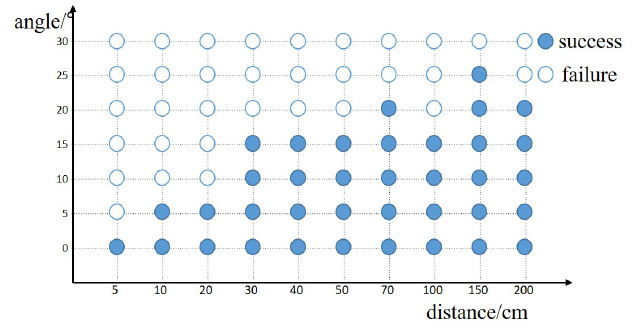
Figure 16. Success and failure results of docking experiments in different